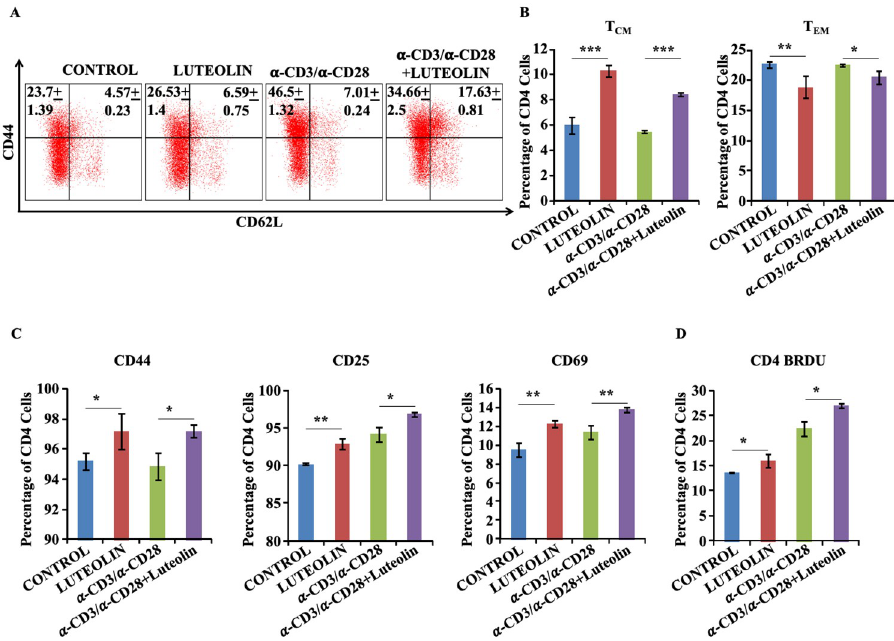
Fig 1. Luteolin biases T cells towards a T CM phenotype after in vitro activation with plate bound α -CD3 & soluble α -CD28 antibodies. (A&B) Memory responses of CD4 + T cells in vitro . (C) T lymphocytes were activated in vitro with plate-bound α -CD3 & soluble α -CD28 antibodies in the presence or absence of luteolin and then stained with anti- CD4, -CD62L, -CD25, -CD44 and -CD69 mAbs. (D) T cell proliferation was monitored by BrdU incorporation post activation in vitro by staining with anti-CD4 and -BrdU antibodies. Data represented as the mean ± STDEV values from data pooled from three experiments with five mice per experiment. Differences were considered significant at P < 0.05 using one way ANOVA. � p < 0.05, �� p < 0.005, ��� p <